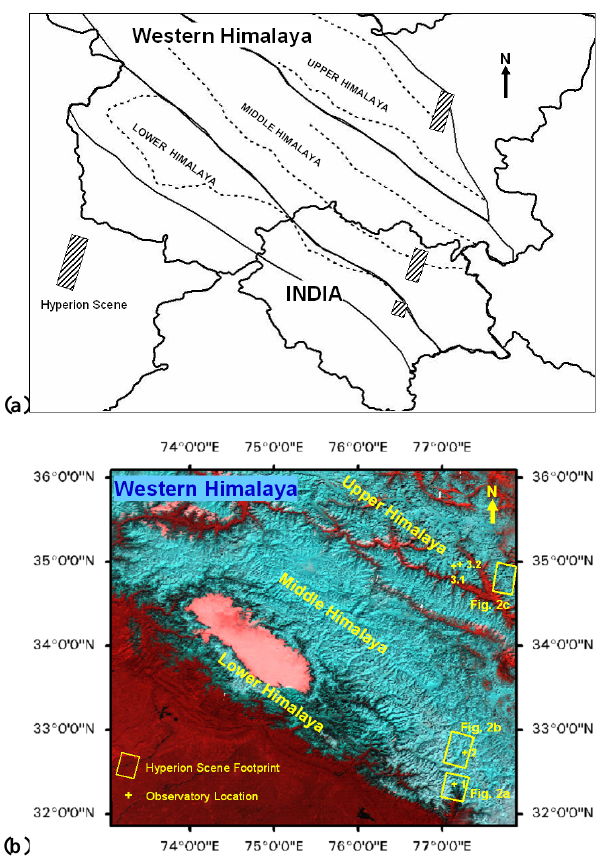
Fig. 1. (a) The layout of western Himalaya with different snow cli- matic zones and selected study areas; (b) satellite perspective view of western Himalaya with footprint of selected Hyperion scenes and corresponding observatory locations for each Himalayan